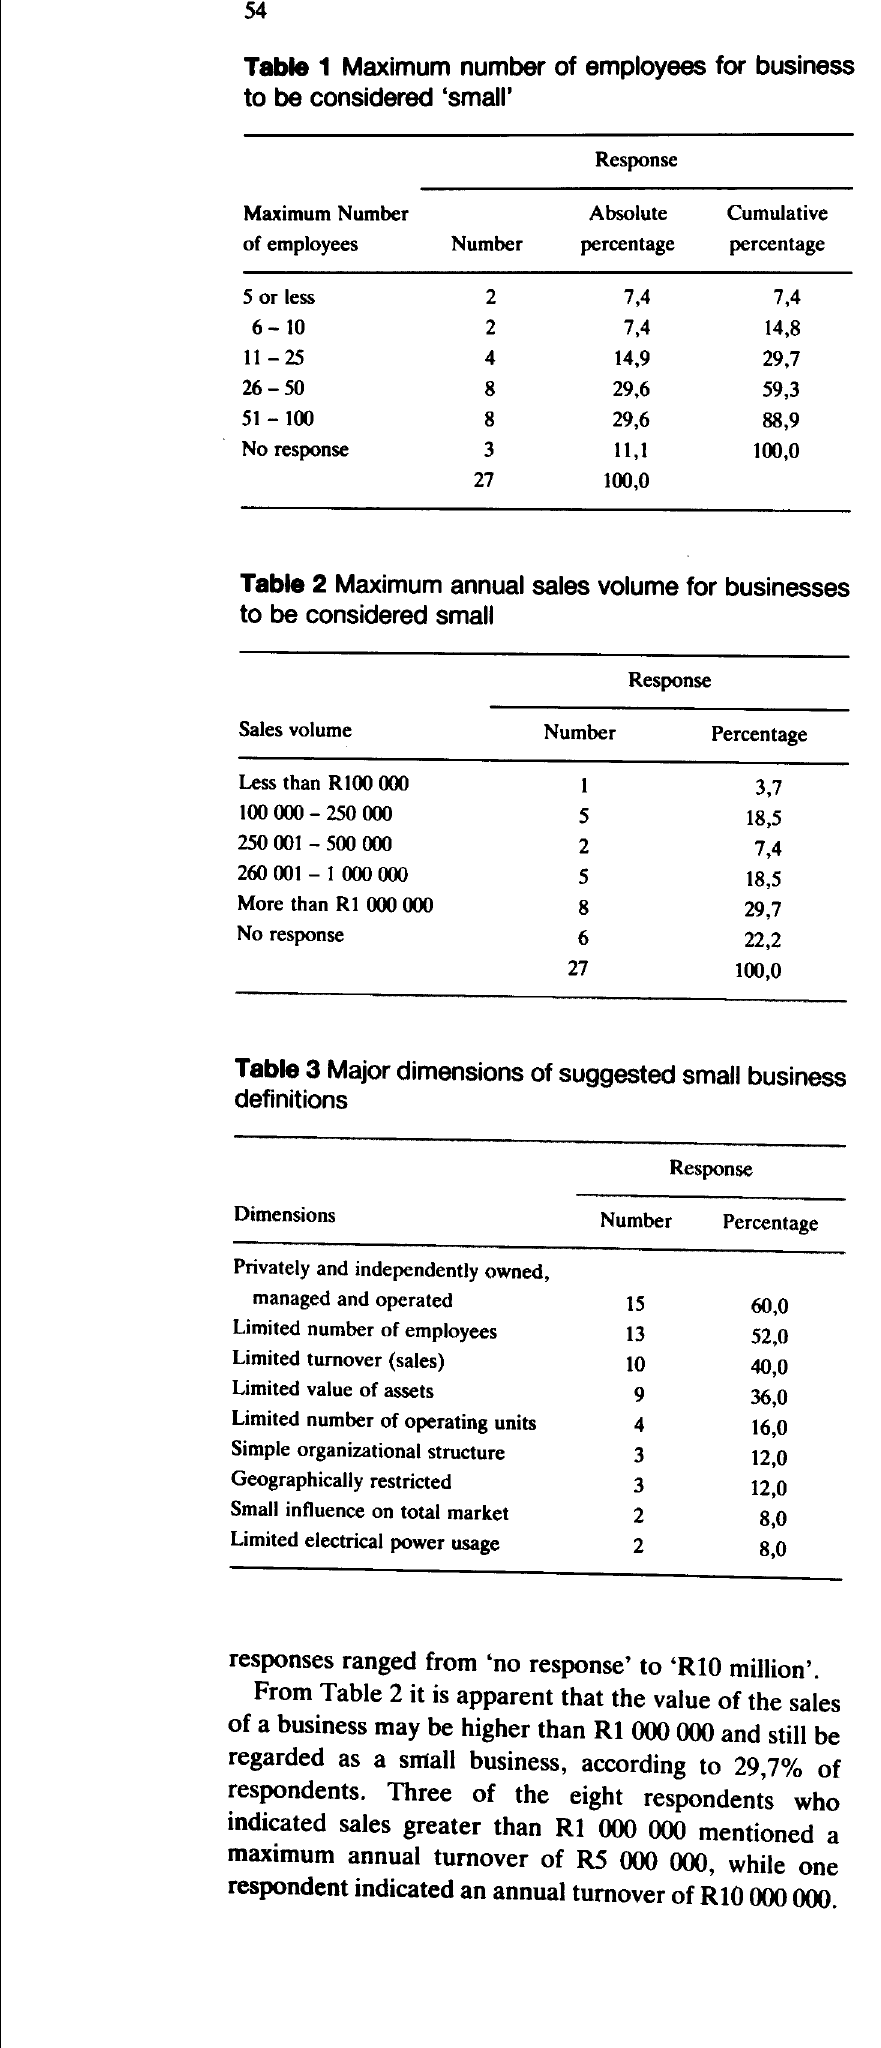
Table 1 Maximum number of employees for business to be considered 'small'